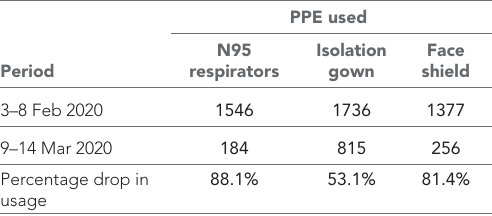
Table 2 Comparison of weekly consumption of PPE in 8 General Outpatient Clinics before and after the implementation of the new system